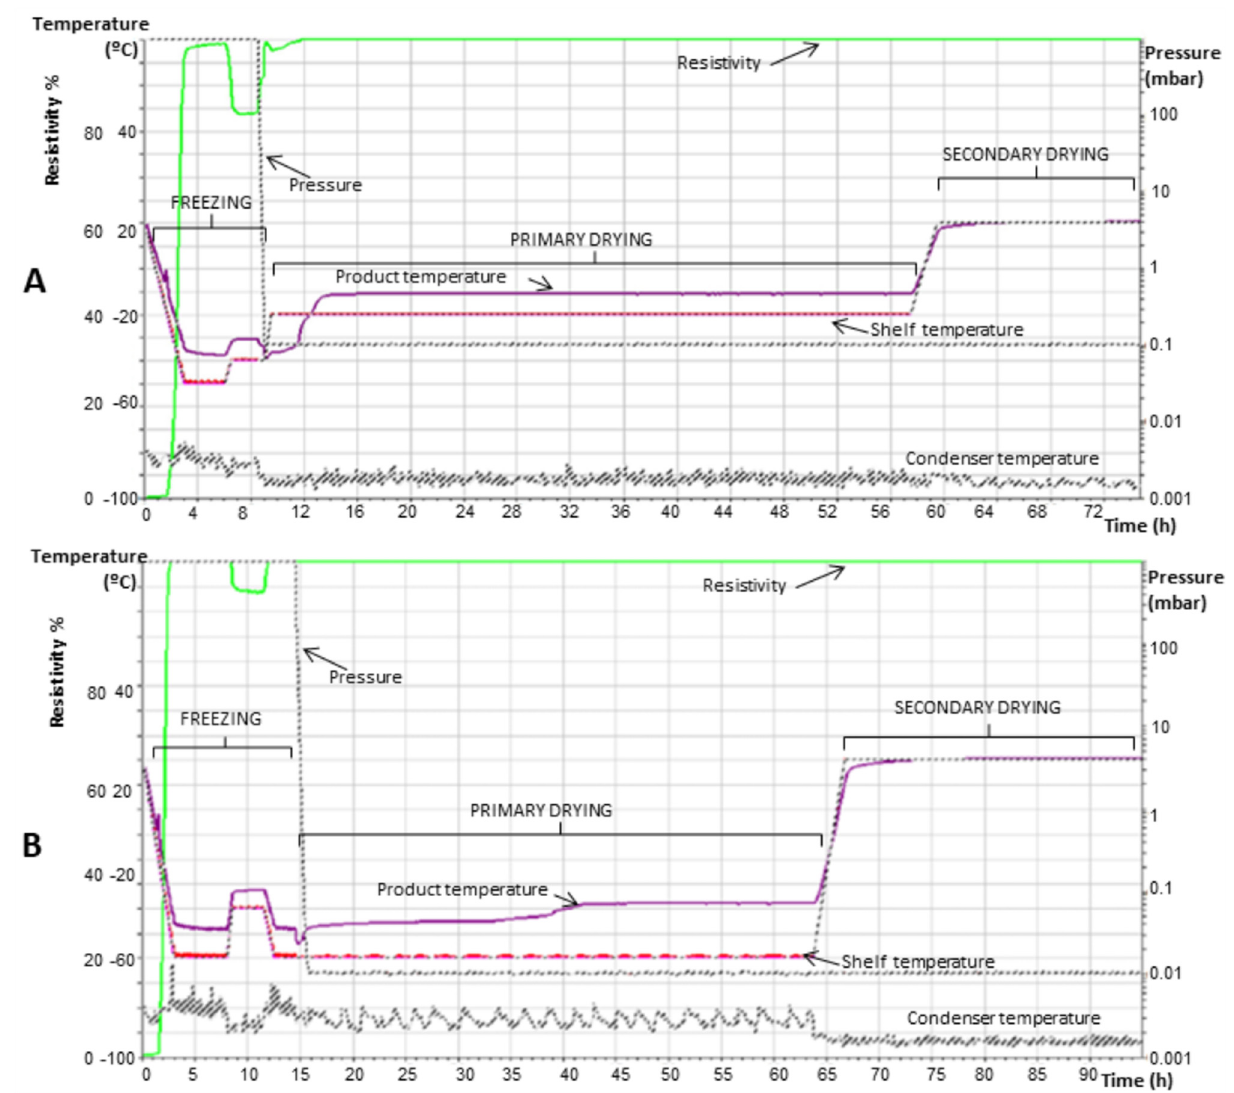
Figure 1. Graph of the complete freeze-drying process using cycles 1 ( A ) and 2 ( B ). Graph of freeze- drying of LCFL-PTX/DXR added of trehalose 9:1 w / w in relation to the phospholipids. Cycle 1 lasted 74 h and cycle 2 lasted 90